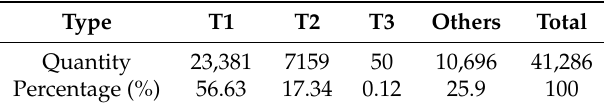
Table 11. Distribution of the main types of errors made by the proposed CFE encoder for the test set of experiment E3. Type T1 T2